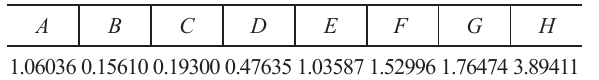
Table 3 – Parameters required for calculating viscosity Parameter He CH M (g mol –1 )